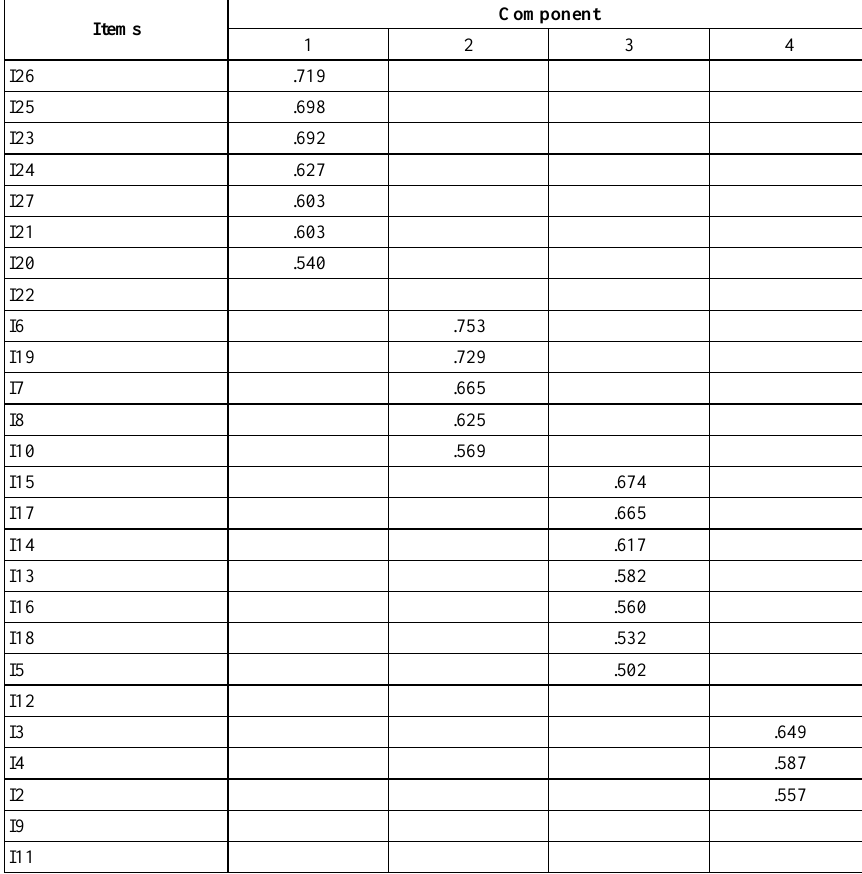
Table 7. Rotated component